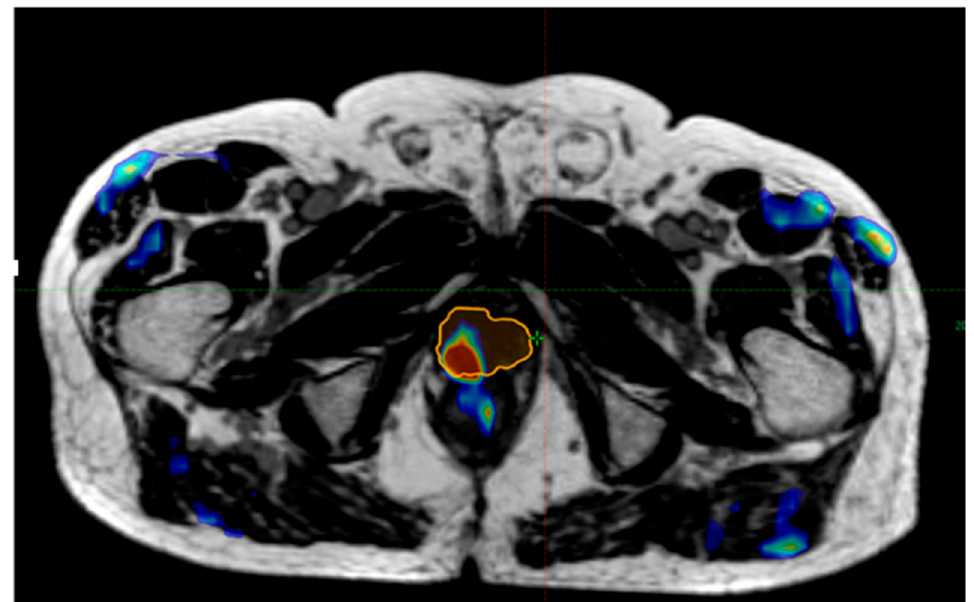
Figure 2. Example of an intraprostatic persistent disease. This patient presented a PSA level increase of more than 50% compared to post-reirradiation nadir at 9 months post-treatment. A registration was done between the MRIdian ® simulation image for reirradiation with PTV in orange line and the Choline-PET/CT performed after this rising PSA. This registration highlighted a persistent hyperfixation within the treated volume.